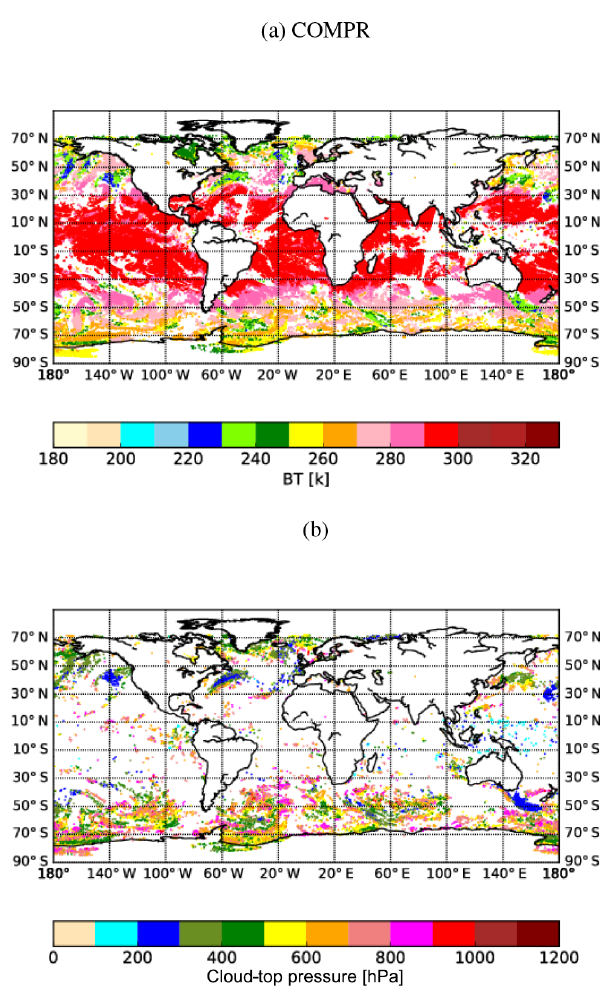
Figure 5. Map of IASI observations of brightness temperature (K) for surface channel (1271, 962.5cm − 1 ), after applying the COMPR method (a) , cloud-top pressure (hPa) retrieved from a CO 2 -slicing algorithm applied to IASI observations (b) , for 30 January 2017 daytime over